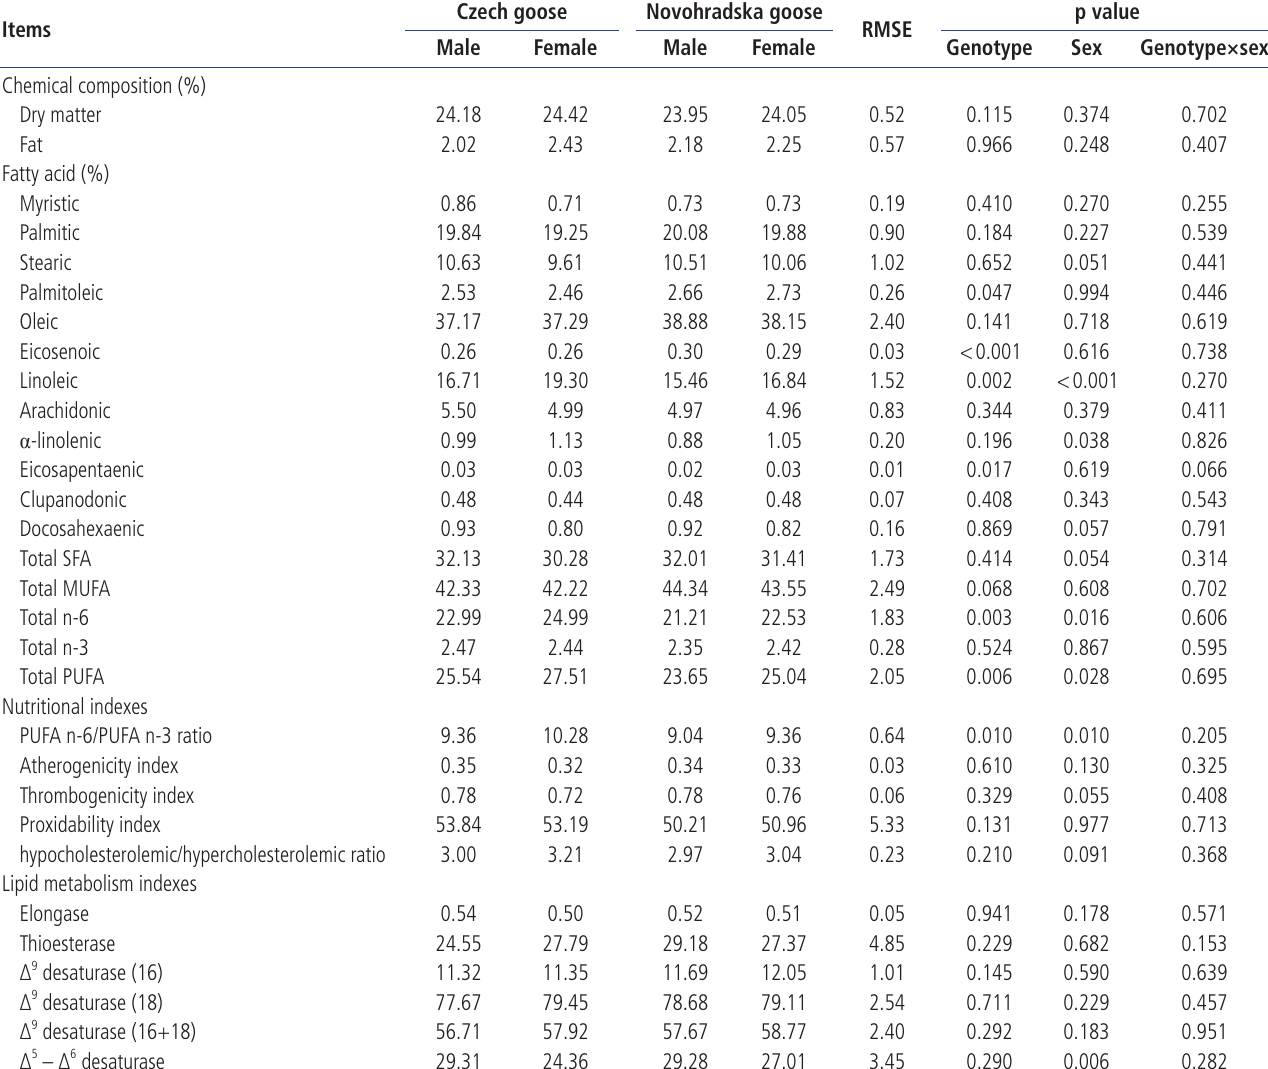
Table 3. Chemical composition, fatty acid composition, nutritional indexes and lipid metabolism indexes of goose meat according to genotype and sex